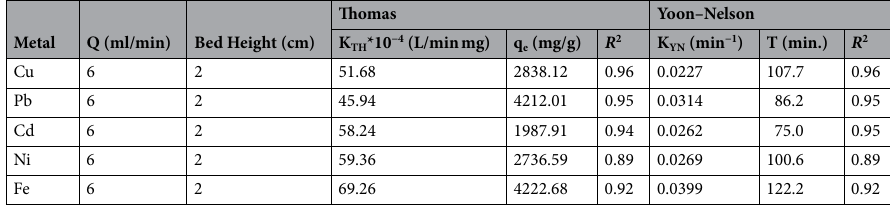
Table 3. Parameters of Thomas and Yoon-Nelson models for fixed bed column adsorption